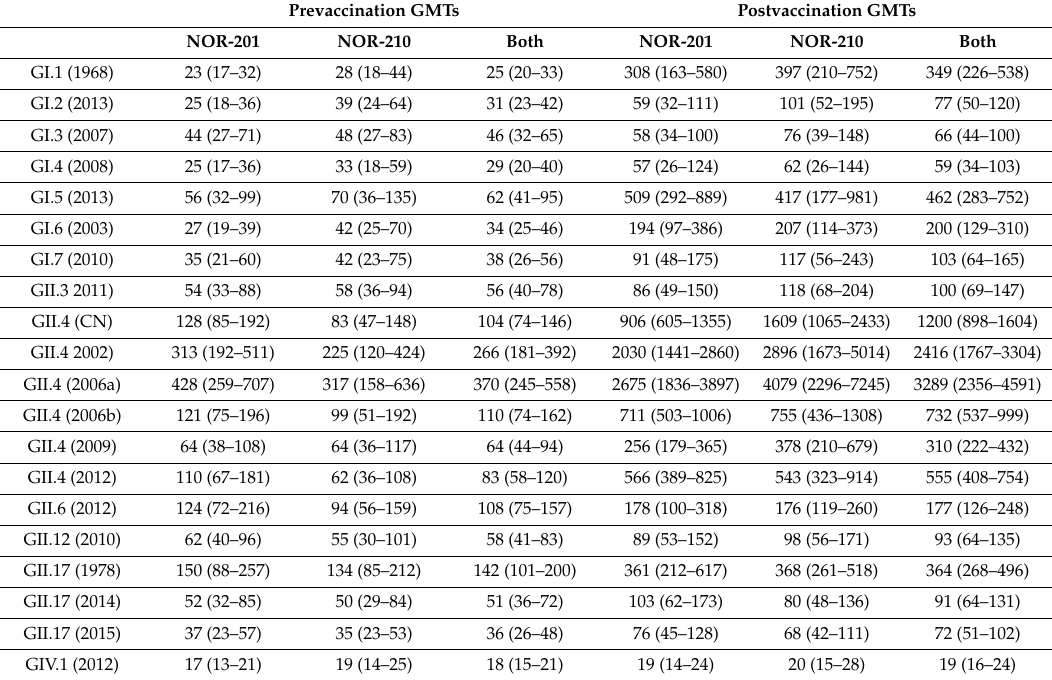
Table 4. Geometric mean titers before and after